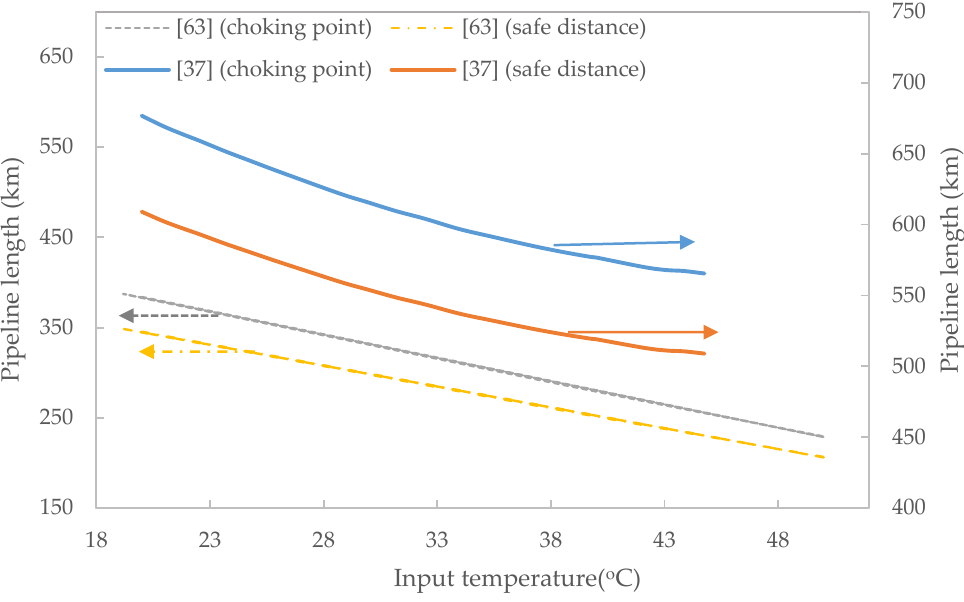
Figure 3. Variations of maximum safe CO 2 pipeline length and choking point for different input temperatures [37,63].